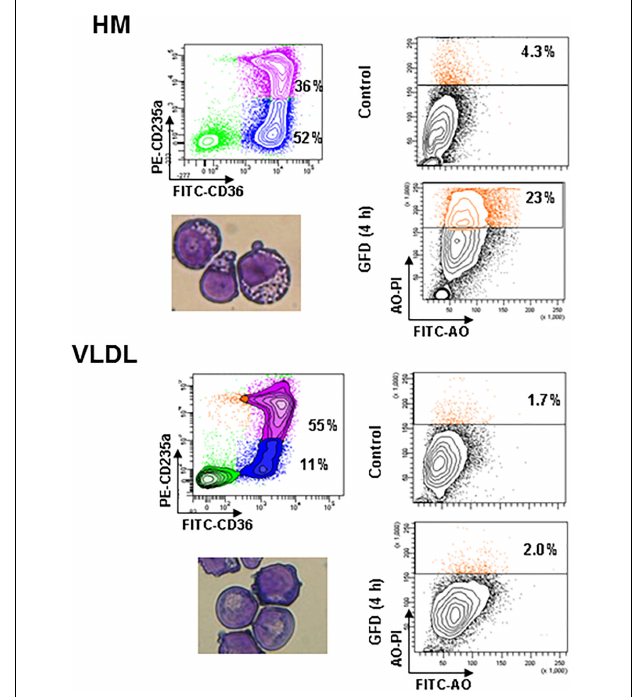
FIGURE 5 | Erythroblasts generated in the presence of VLDL are resistant to autophagic death induced by growth factor deprivation. The panels on the left present the flow cytometry and morphological analyses of erythroblasts generated by days 10 in HEMA def supplemented either with HM liposomes or with VLDL (20 µ L/mL). The panels on the right compare the frequency of Acrydine Orange (AO) positive cells, as indication of autophagic death, of the two populations when cultured for 4 h with (Control) or without growth factors (growth factor deprived, GFD). Results are representative of those obtained in two separate